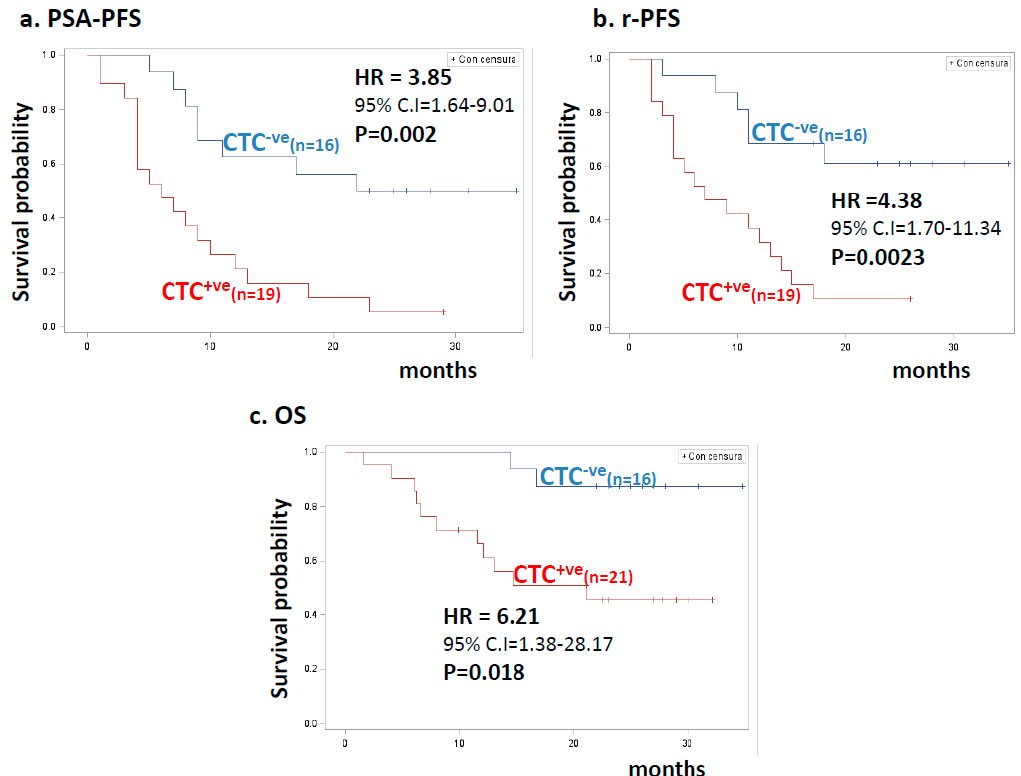
Figure 1. Kaplan–Meier estimates for clinical outcome in patients stratified by CTC status. ( a ) PSA-progression-free survival (PSA-PFS) according to CTC status. Blue and red lines indicate 16 CTC-negative (CTC − ve ) and 19 CTC-positive (CTC + ve ) patients, respectively. HR values, 95% confidence interval (CI), number of patients, and statistical significance are reported in the inset. ( b ) Radiologic progression-free survival (rPFS) according to CTC status. Blue and red lines indicate 16 CTC-negative (CTC − ve ) and 19 CTC-positive (CTC + ve ) patients, respectively. HR values, 95% confidence interval (CI), number of patients, and statistical significance are reported in the inset. ( c ) Overall survival (OS) according to CTC status. Blue and red lines indicate 16 CTC-negative (CTC − ve ) and 21 CTC-positive (CTC + ve ) patients, respectively. HR values, 95% confidence interval (CI), number of patients, and statistical significance are reported in the